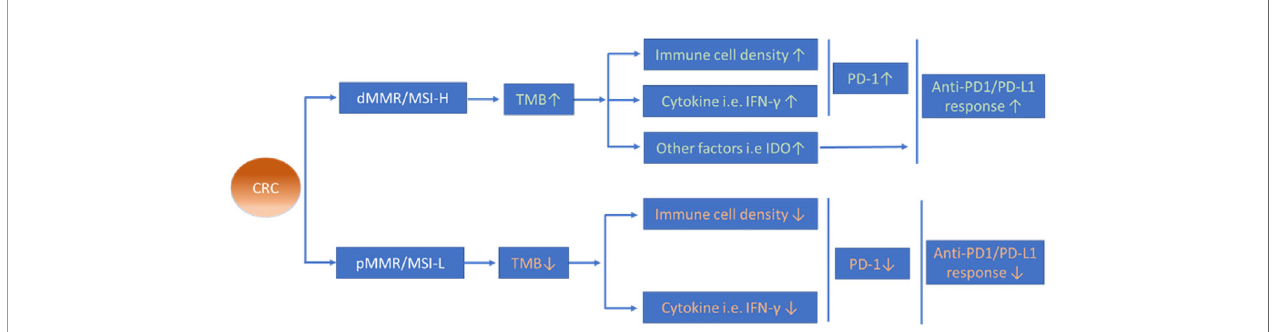
FIGURE 3 | Possible mechanisms of different anti-PD-1/PD-L1 therapeutic ef fi cacy between CRC with dMMR/MSI-H and pMMR/MSI-L. Increased TMB in dMMR/ MSI-H CRCs is proposed to induce higher in fi ltration of immune cells and expression level of cytokines in the tumour microenvironment that might contribute to the distinct therapeutic ef fi cacy of anti-PD-1/PD-L1 therapy between dMMR/MSI-H CRCs and